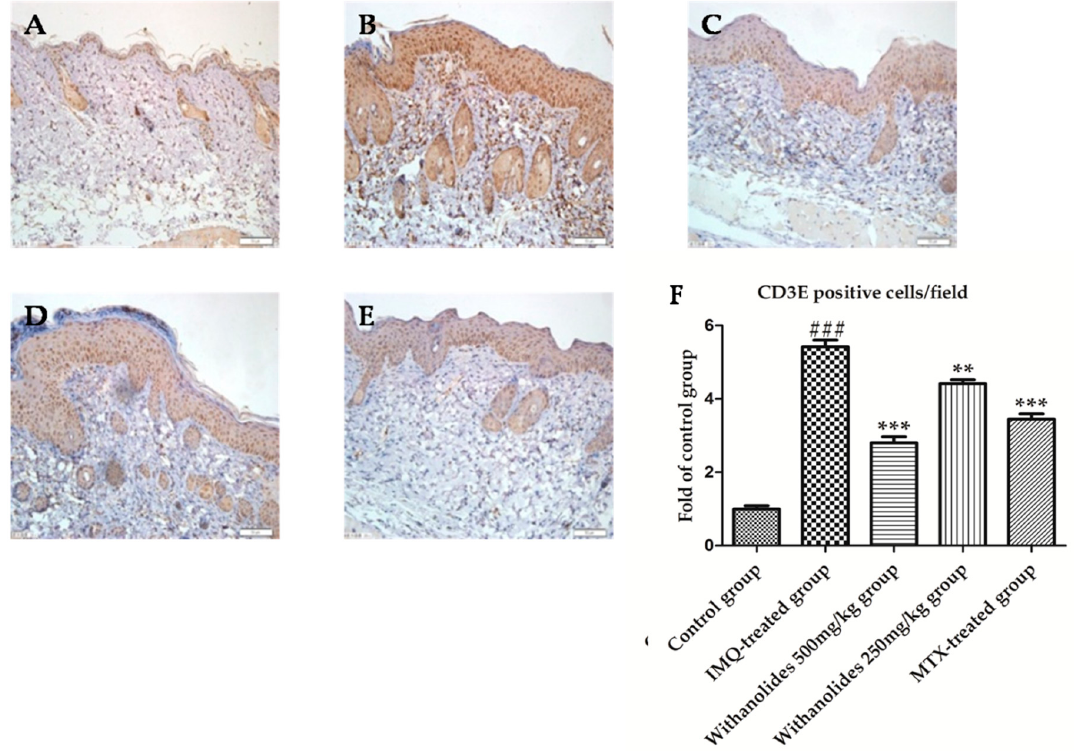
Figure 6. The psoriasis-like skin sections were strained by immunohistochemistry to evaluate CD3E in five groups. ( A ) Control group. ( B ) IMQ- treated group. ( C ) Withanolides 500 mg/kg group. ( D ) Withanolides 250 mg/kg group. ( E ) MTX-treated group. ( F ) CD3E positive cell/field (IF ×400). ** p < 0.01 vs. IMQ-treated group, *** p < 0.001 vs. IMQ-treated group, ### p < 0.001 vs. control group.